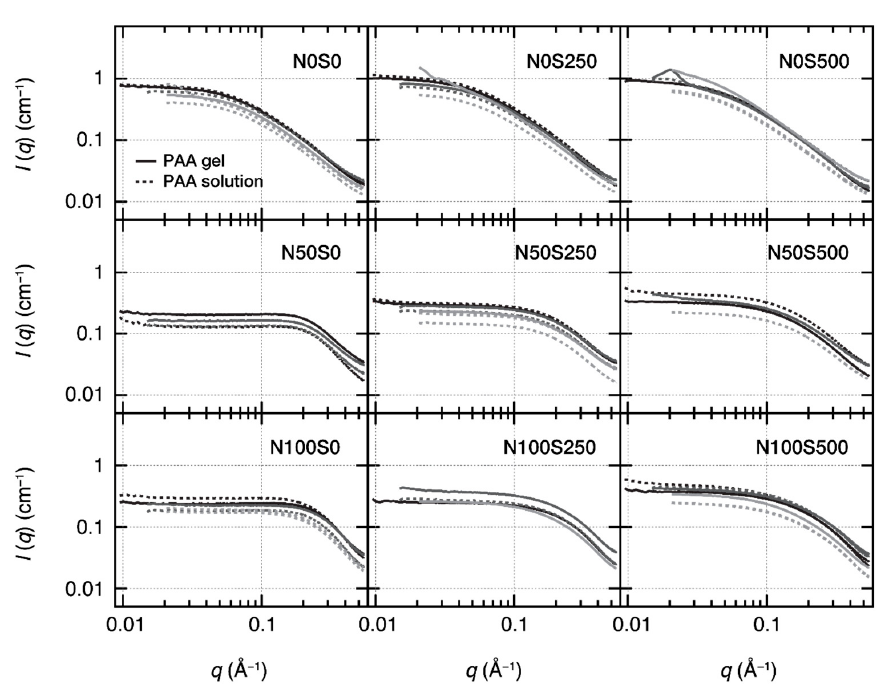
Figure 4. SAXS profiles of the equilibrated equivolume PAA gels (solid curves) and the correspond- ing noncrosslinked PAA solutions (dotted curves) with different neutralization degrees and salt concentrations. Each panel shows three independent SAXS experiments, where gels and polymer solutions were prepared on each occasion. The profiles with obvious problems were removed. As the neutralization degrees and salt concentrations will largely affect the small ‐ angle scattering profiles of the polyelectrolytes [13], the SAXS profiles of the PAA gels will be similar to those of the PAA solutions (reservoir) only when the post ‐ ion ‐ tuning com ‐ pletes. Figure 4 shows the SAXS profiles at each condition. The gel SAXS profiles are con ‐ sistent with the sol profiles in each panel within the experimental errors, suggesting that the neutralization degree and the salt concentration in each gel are the same as those in each corresponding PAA solution. This result confirms the completion of the post ‐ ion ‐ tuning, as observed in Figure 2. We also measured the newly prepared PAA solutions and the PAA solutions used for the post ‐ ion ‐ tuning, respectively; no difference was observed in their scattering profiles, indicating that the PAA solutions properly worked as the ion reservoir as we expected. The slight vertical shifts of the profiles in each panel are due to the uncertainty in the sample thickness in our sample environments, which is known to cause ± 20% shifts for the solution samples. The vertical shifts for the gel samples (solid lines) were much smaller than the solutions (dotted lines) because the mold determines the gel thickness. However, as the vertical shifts do not affect the shape of the profiles, they do not affect the discussion in this study. The excellent consistency between the PAA gel and solutions in each condition also suggests a relatively homogeneous network formation in the size range of the SAXS meas ‐ urements (1.3 Å < 2 π / q < 62.8 Å). The anomalous fractal small ‐ angle scattering at q < 0.05 Å − 1 , representing the heterogeneous networks [35], was not observed in Figure 4. How ‐ ever, the dynamic light scattering experiments and laser speckle tests showed that the as ‐ prepared PAA gels are highly heterogeneous in the light scattering size regime (2 π / q = 336 nm) (Figure 5a). Typical scattering results for the spatial heterogeneities, such as the posi ‐ tion ‐ dependent intensity correlation curves ( g 2 ( τ ) − 1), a nonrelaxing component in the ensemble ‐ averaged correlation curve ( g 2E ( τ ) − 1), and the laser speckles, were all observed